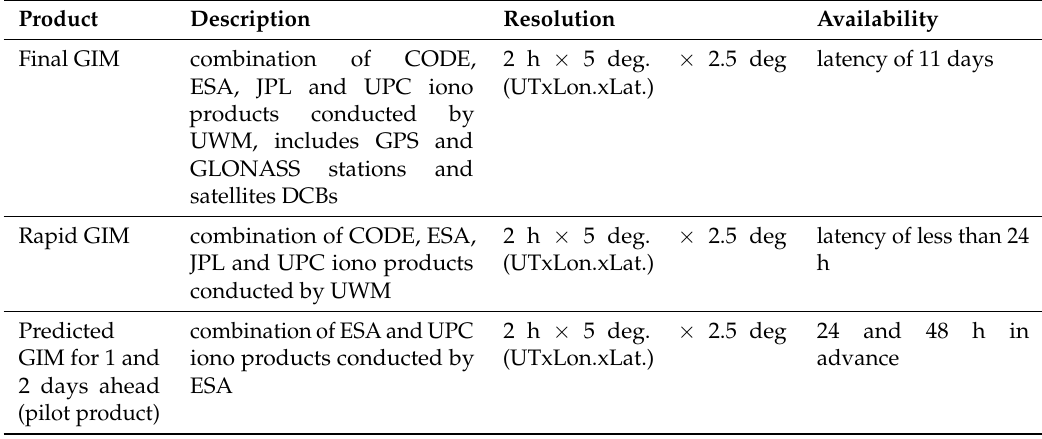
Table 1. IGS IONO WG VTEC products (see: